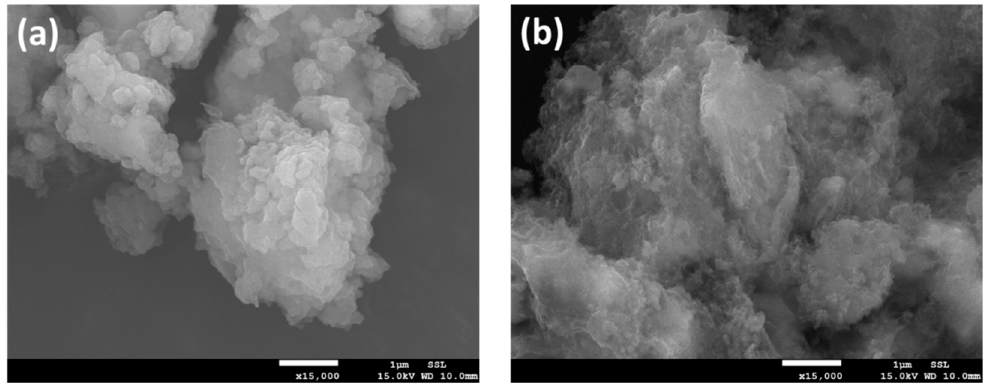
Figure 1. SEM of ( a ) IS-R and ( b )